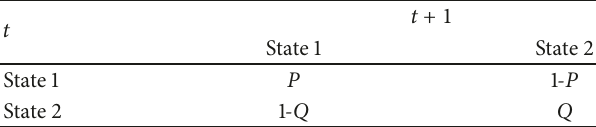
Table 1: Two-state Markov